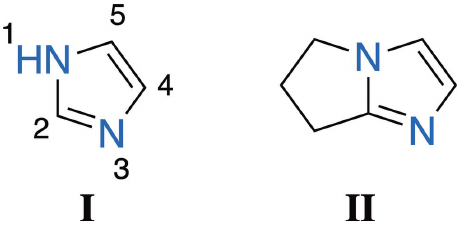
Figure 1 Schematic representation of imidazole ( I ) with atom numbering and of the title derivative ( II